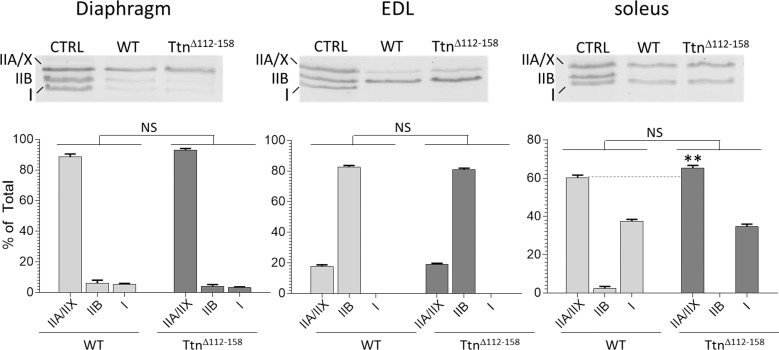
Myosin Heavy Chain (MHC) isoform analysis.Two-way ANOVA reveals that there is no significant difference in MHC isoforms in either diaphragm, EDL, or soleus Ttn∆112-158 muscles compared to WT controls. A multiple comparison analysis only reveals a difference in soleus muscle where IIA/IIX MHC is increased from 60% in WT to 65% in Ttn∆112-158 mice.